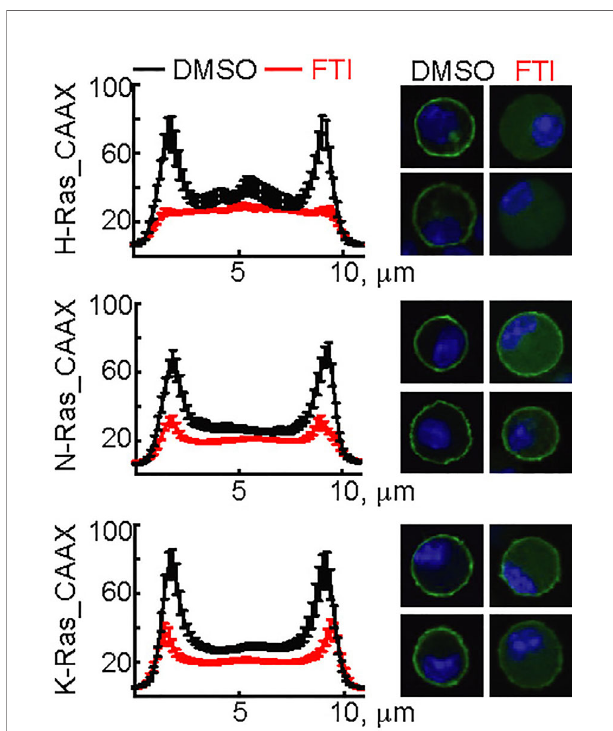
FIGURE 3 | Action of FTI-277 on Ras membrane localization. BMMCs were transfected with constructs expressing GFP-tagged CAAX-domain (C-terminal 25 amino acids) of H-Ras, N-Ras or K-Ras and treated with 5µM FTI-277 for 72 h. Cells were fi xed in 4% p-formaldehyde, and images were acquired by confocal microscopy. The image squares have a length of 10 µm. Left side graphs show distribution of Ras protein along a cross-section of the cell. For each condition n ≥ 18 cells were analyzed. Plotted are mean values ± standard error of mean